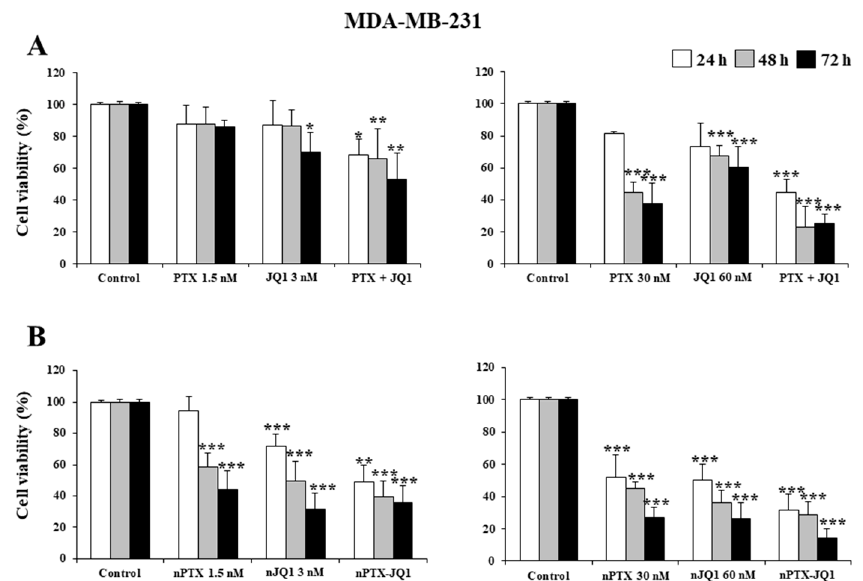
Figure 3. Effects of JQ1 and PTX on TNBC cell viability. MDA-MB-231 cells were treated with JQ1 and PTX as a free form ( A ) or encapsulated in zein nanoparticles ( B ) as single agents (nJQ1, nPTX) or as multidrug carriers (nJQ1-PTX). Each experiment was performed in triplicate and values are expressed in % over untreated cells (control), as mean ± SD. Statistical analysis was performed using the Tukey–Kramer multiple comparisons test. * p < 0.05, ** p < 0.01, *** p < 0.001 vs. control.